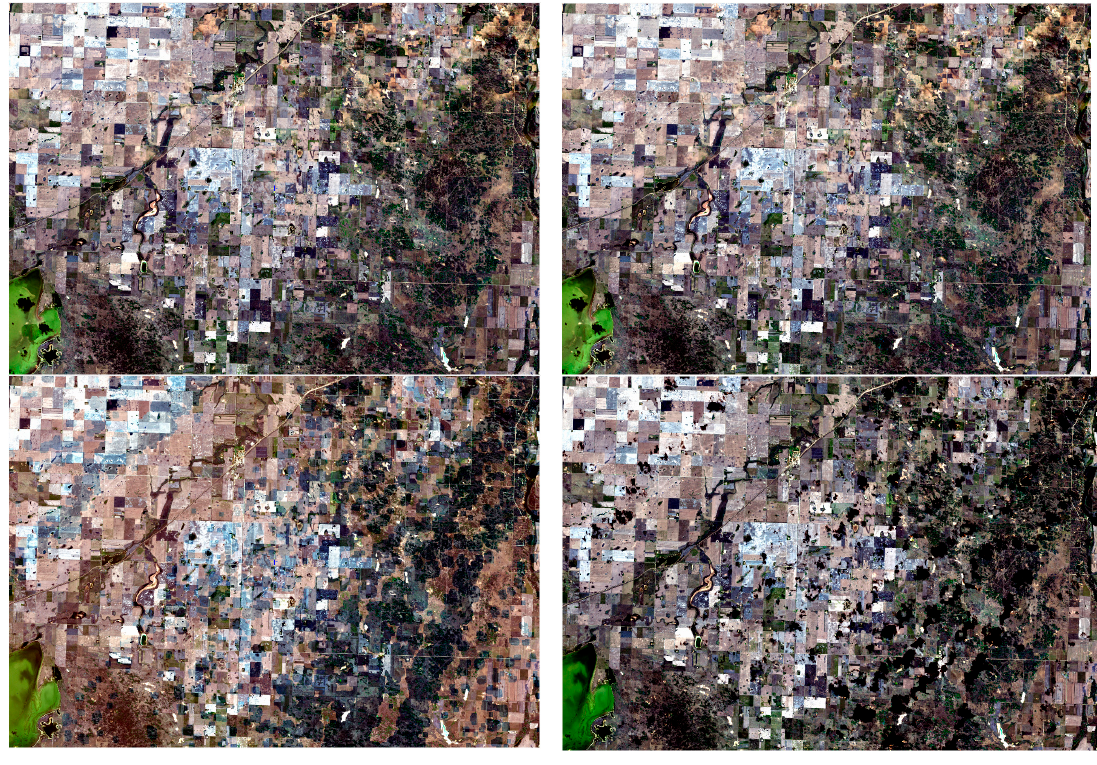
Figure 9. Comparison of the reconstructed images before and after the normalization process of the dates of 16 May, 15 June, 30 July, 21 August, and 3–5 October 2018 (from top to bottom). Remote Sens. 2020 , 12 , x FOR PEER REVIEW 19 of 23